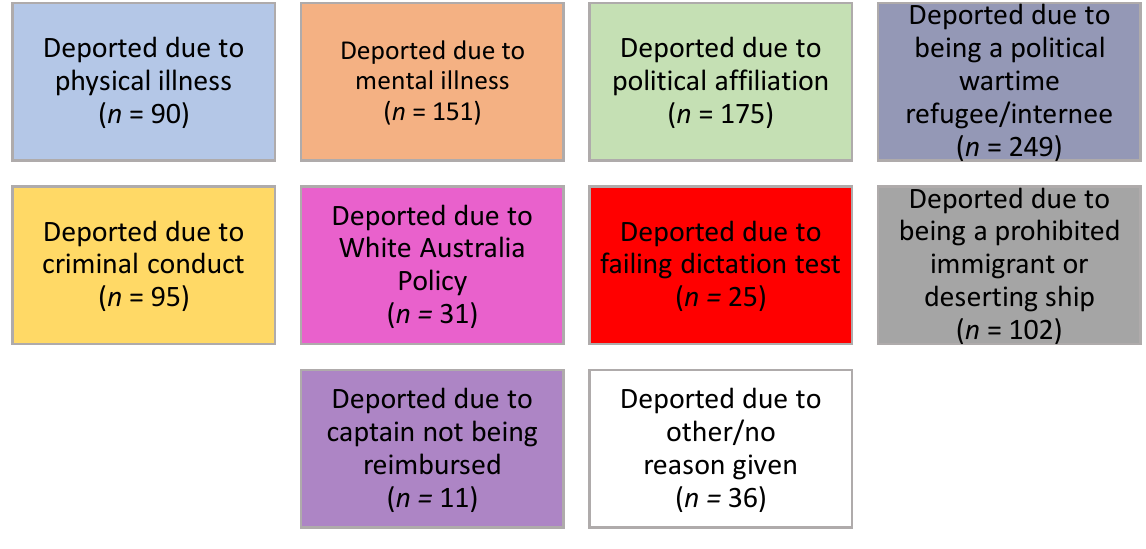
Figure 1: Reasons for